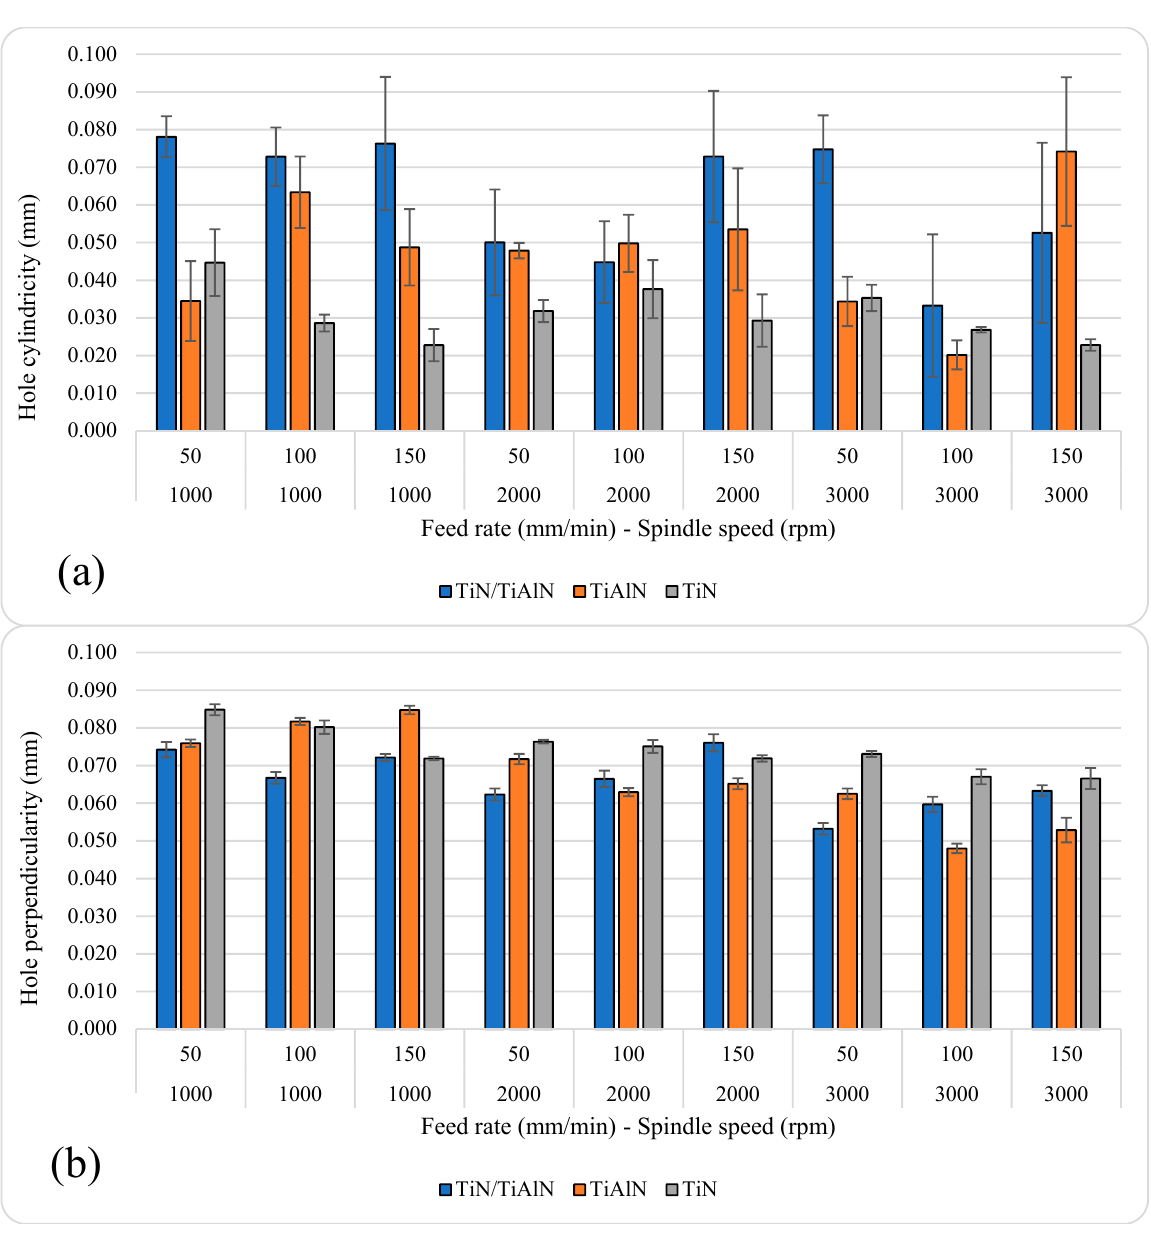
Figure 10. Average hole ( a ) cylindricity and ( b )